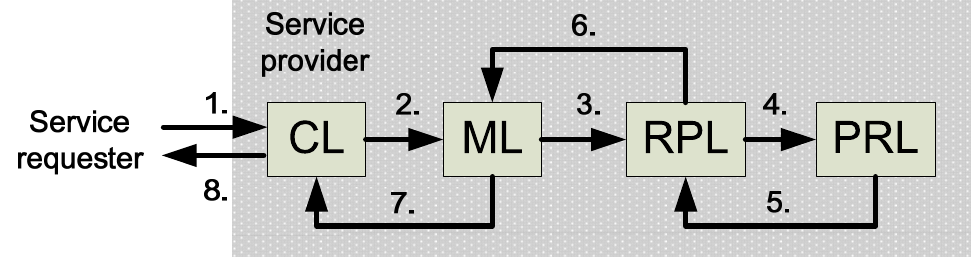
Figure 8. The interaction process flow for accessing the logistic cloud.